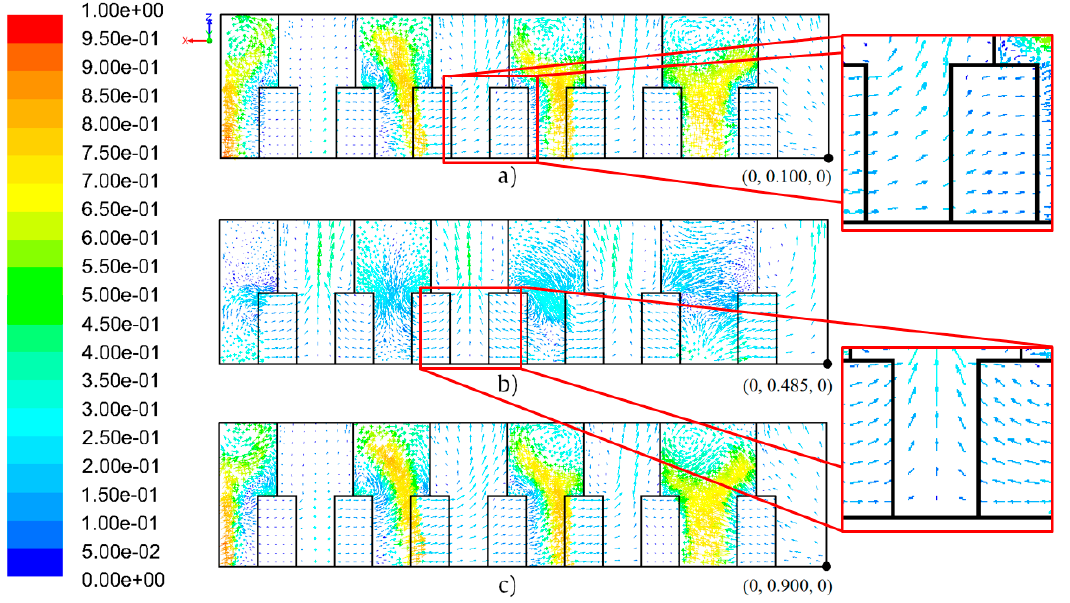
Figure 26. The results of the dimensionless velocity vectors for the maximum air flow velocity in the x–z plane represented through the planes: ( a ) y adm = 0.100; ( b ) y adm = 0.485; and ( c ) y adm = 0.900.